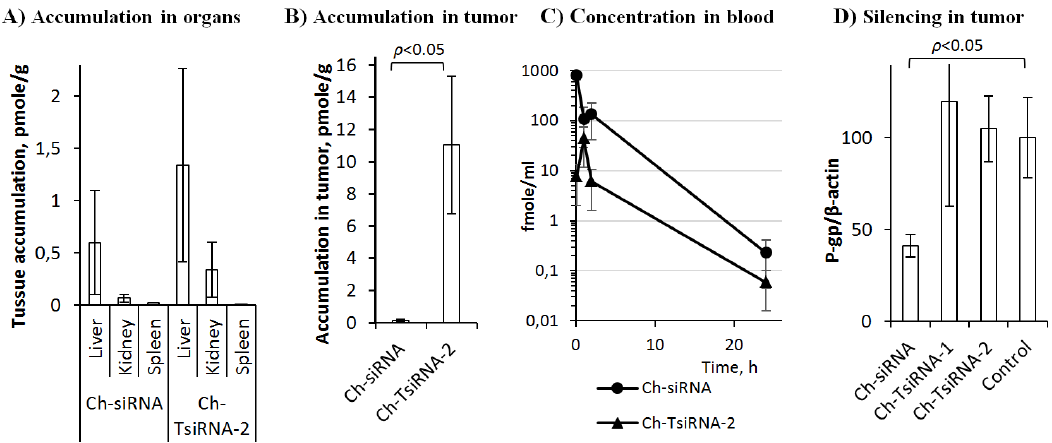
Figure 2. Biodistribution ( A – C ) and silencing activity in vivo ( D ) of cholesterol-modified siRNAs. ( A ) Biodistribution of Ch-siRNA and Ch-TsiRNA-2 in organs of mice 24 h after i.v. injection (2.5 nmole — 1.7 and 5 µg/g, respectively). ( B ) Accumulation of Ch-siRNA and Ch-TsiRNA-2 in xenograft KB-8-5 tumors 24 h after i.v. injection (1.1 nmole — 0.5 and 1.5 µg/g, respectively). ( C ) Concentration of Ch-siRNA and Ch-TsiRNA-2 in the blood of mice after i.v. injection of 2.5 nmole — 1.7 and 5 µg/g, respectively. ( D ) Silencing activity of Ch-siRNA, Ch-TsiRNA-1 and Ch-TsiRNA-2 in xenograft KB-8-5 tumors in 24 h after i.v. injection (8.5 µg/g).